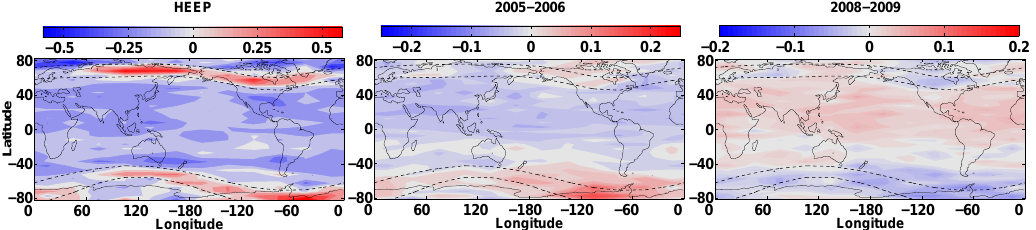
Fig. 6. OH anomalies for 3 selected data sets: (1) HEEP (left panel), (2) ECR < 5 between 2005–2006 (middle panel) and (3) ECR < 5 between 2008–2009 (right panel).